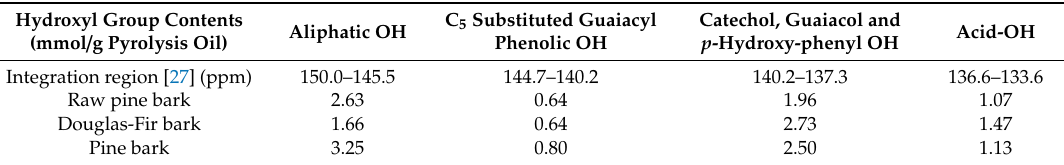
Table 6. Hydroxyl group contents of pyrolysis oil produced from raw pine bark, pine, and Douglas-Fir bark at 500 ◦